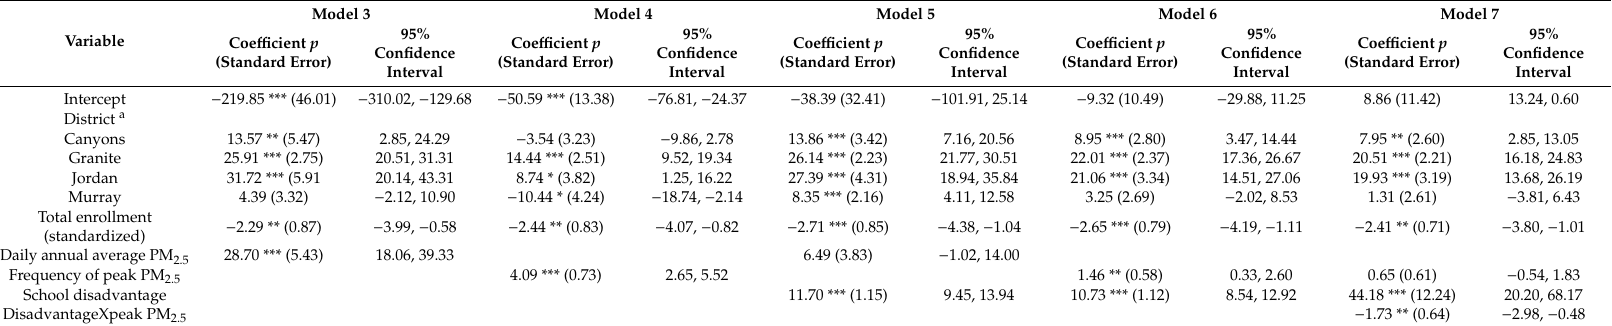
Table 3. Results of the Generalized Estimating Equations (GEEs) predicting the percentage of students below proficient in math at Salt Lake County public primary schools ( n = 156).